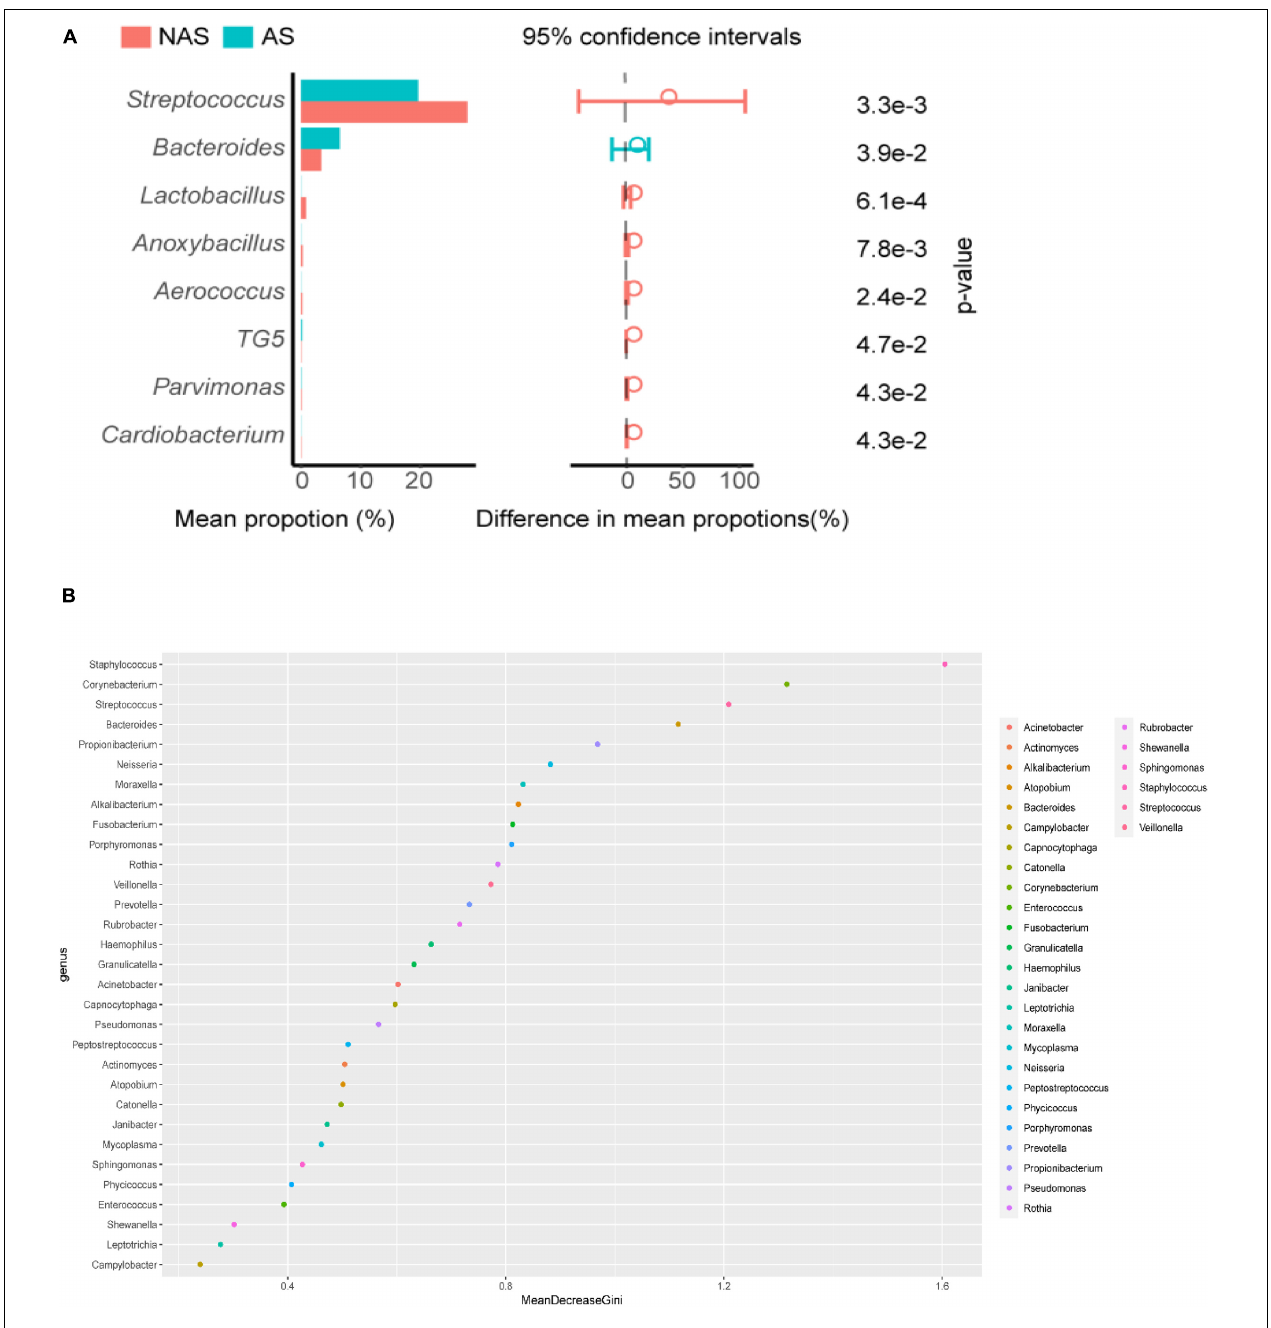
FIGURE 3 | Streptococcus , Bacterodies , Lactobacillus , Anoxybacillus , Aerococcus , TG5, Pavimonas, and Cardiobacterium showed significant differences ( p < 0.05) between the no allergy sensitivity (NAS) group and allergy sensitivity (AS) group (A) . Color spots of the relative abundances of 30 species selected for the random forest (RF) model used to distinguish samples in no allergy sensitivity (NAS) group and allergy sensitivity (AS) group (B)